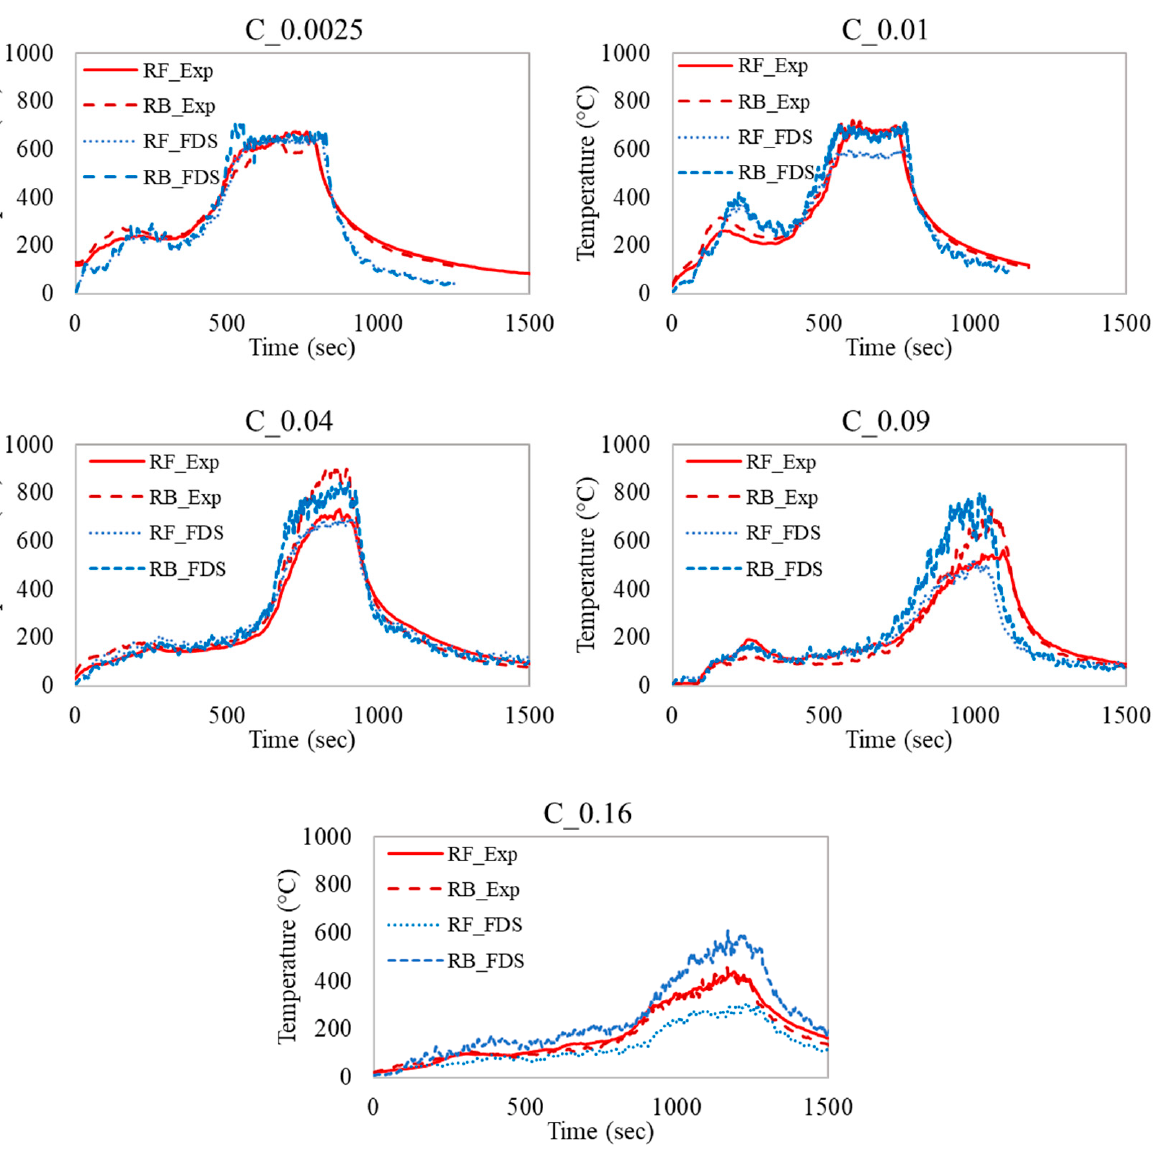
Figure 18. Gas layer temperature for corner cases.